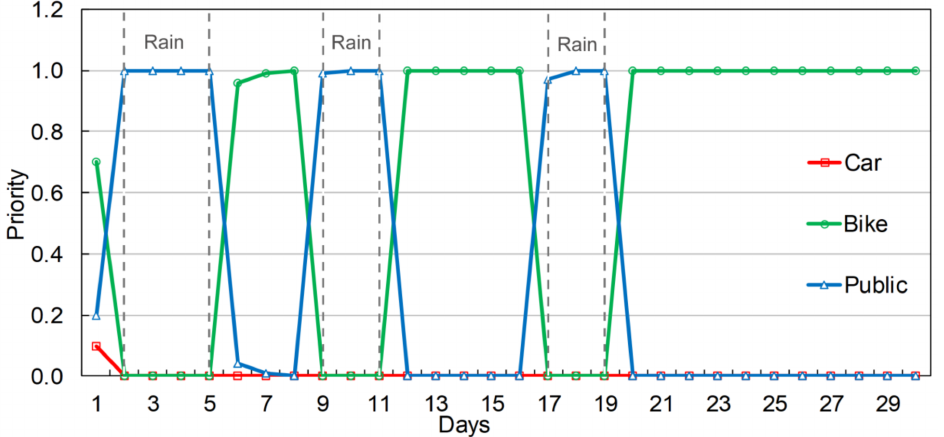
Figure 5. Changes in priority i,k if rain is turned on and off for the agent Alfred. The red ranges are representing the days when the agent is exposed to rain. The y-axes represents the priority for each mode of